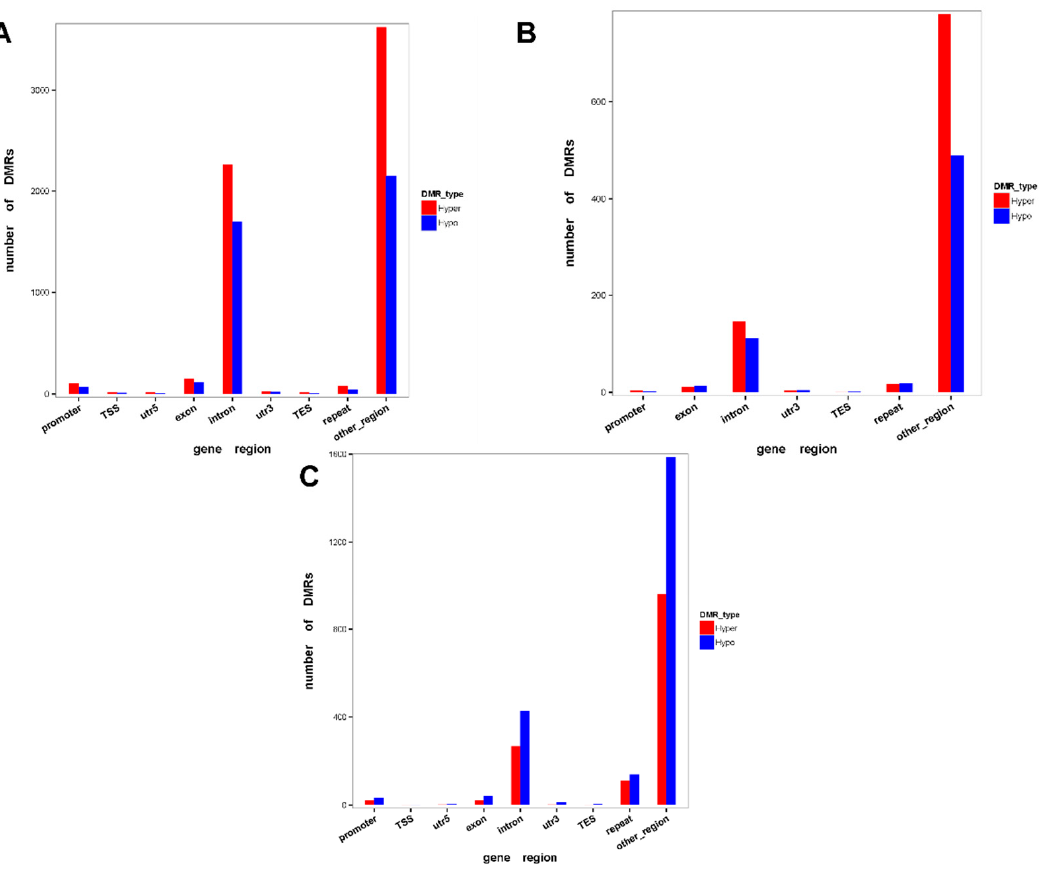
Figure 3. DMRs methylation levels of the H . longicornis adults with or without treatment at 4 °C for six days. ( A ). Distribution of cold vs. control CG DMRs in different regions of the genome. ( B ). Distribution of cold vs. control CHG DMRs in different regions of the genome. ( C ). Distribution of cold vs. control CHH DMRs in different regions of the genome. TES: transcription end site, TSS: transcription start site.